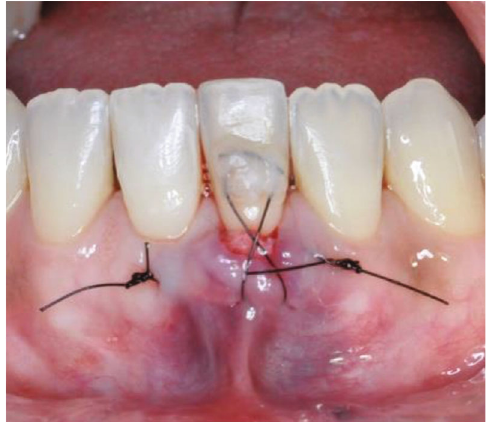
Figure 7: Graft positioned on the receiving area.